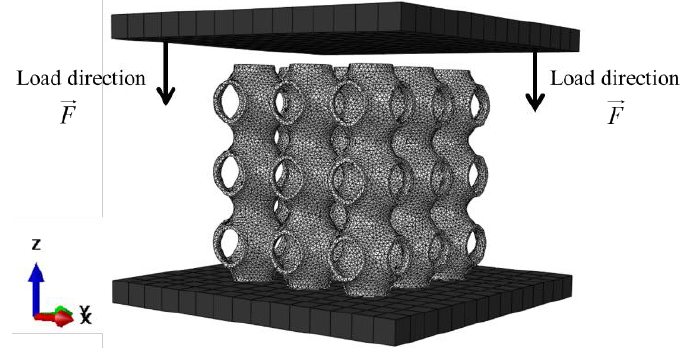
Figure 5. FE model of P-TPMS subjected to quasi-static